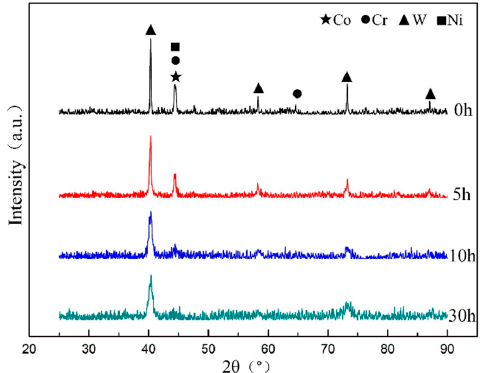
Figure 1. X-ray diffraction patterns of the powders ball milled for different time.